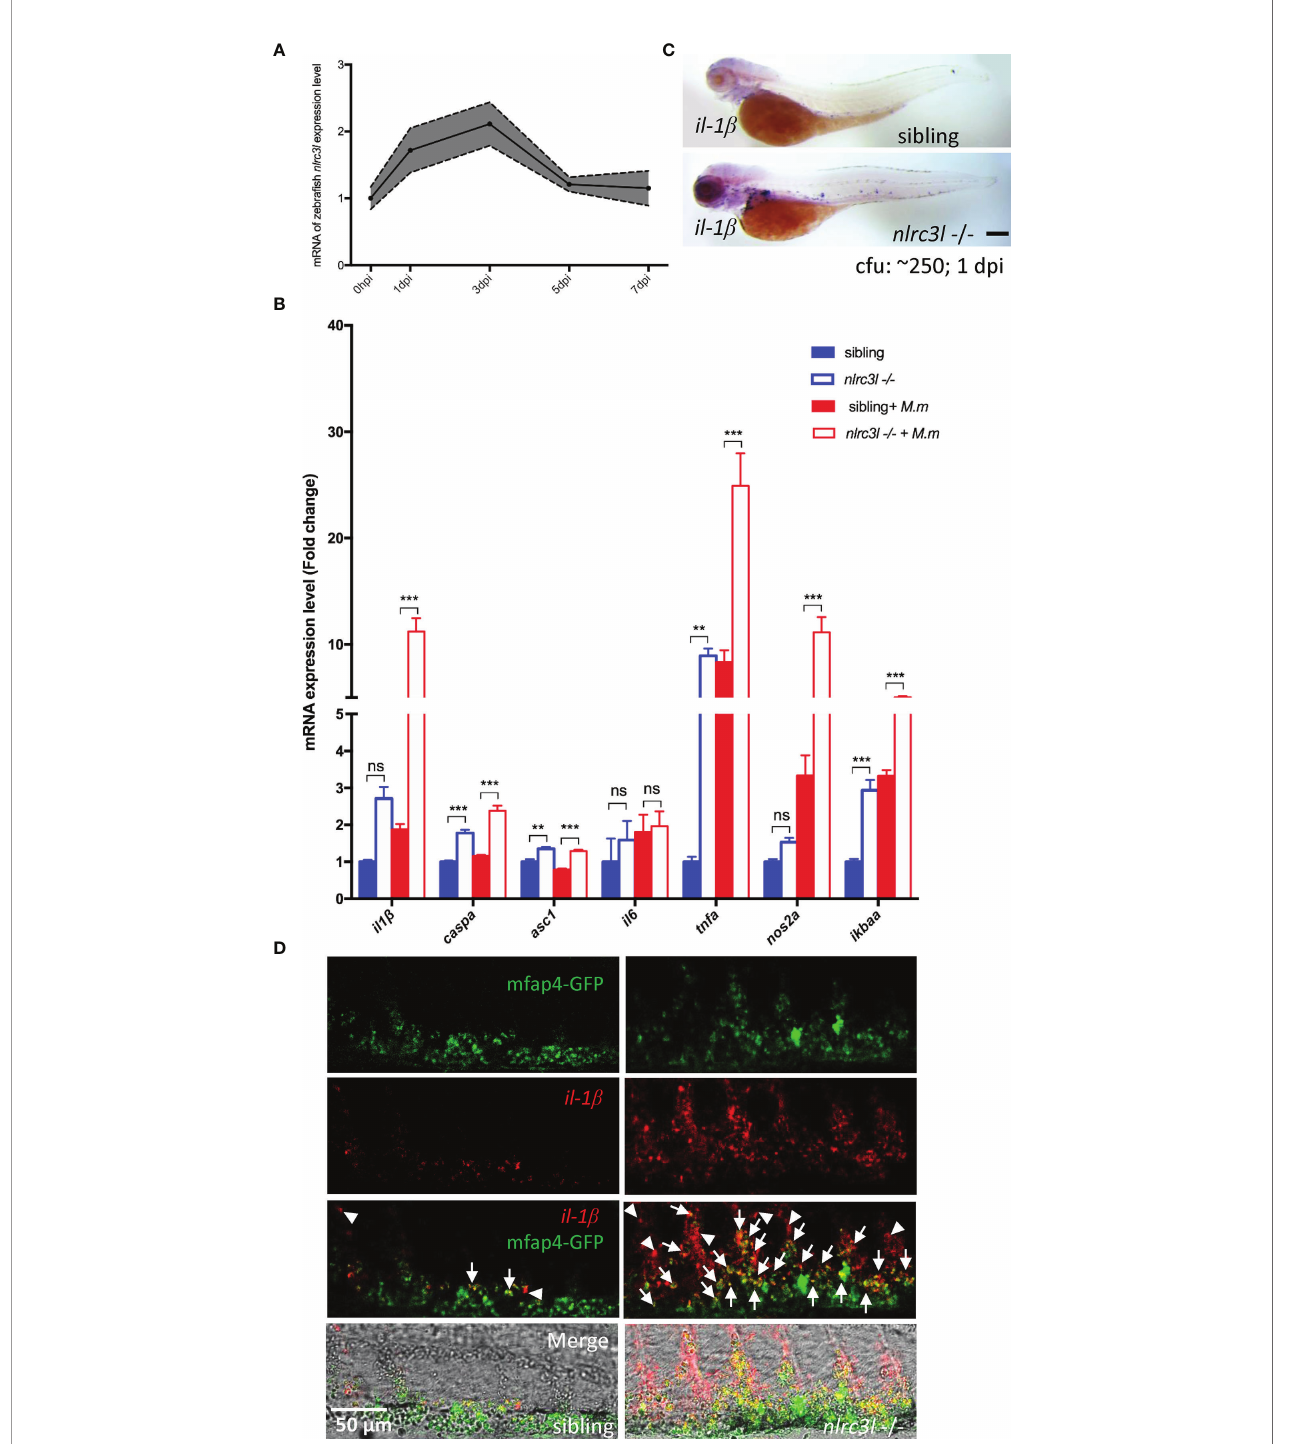
FIGURE 2 | nlrc3-like de fi ciency upregulates the expression of in fl ammatory genes during mycobacterial infection. (A) Quantitative RT-PCR showing expression of nlrc3-like in 3 dpf zebra fi sh embryos at 0, 1, 3, 5 and 7 days post infection with M. marinum : Wasabi. (B) Quantitative RT-PCR showing expression of multiple in fl ammatory genes at 1 dpi. The values shown represent an average of three independent biological experiments, 25 embryos per group in each experiment. (C) il-1 b WISH shows signi fi cantly increased il-1 b expression in nlrc3-like de fi cient mutants compared with their siblings at 1 dpi. Scale bar = 200 m m. (D) Co- staining of il-1 b WISH (red) and anti-GFP antibody (green). White arrows point to co-staining signals of mfap4-GFP and il-1 b , and white arrow heads point to the il-1 b only signals. Scale bar = 50 m m **p ≤ 0.01; ***p ≤ 0.001; ns, not statistically signi fi cant